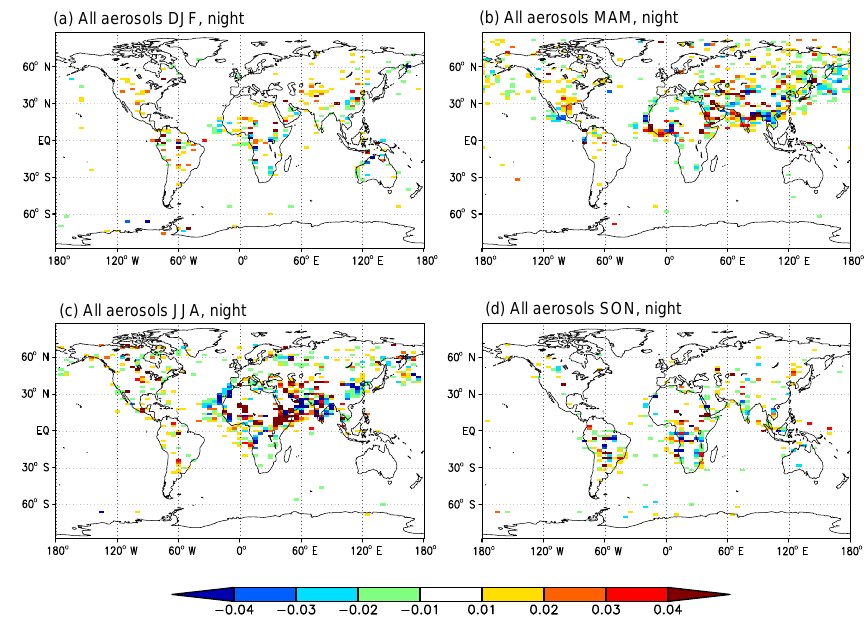
Figure 6. Same as Fig. 2 except for nighttime